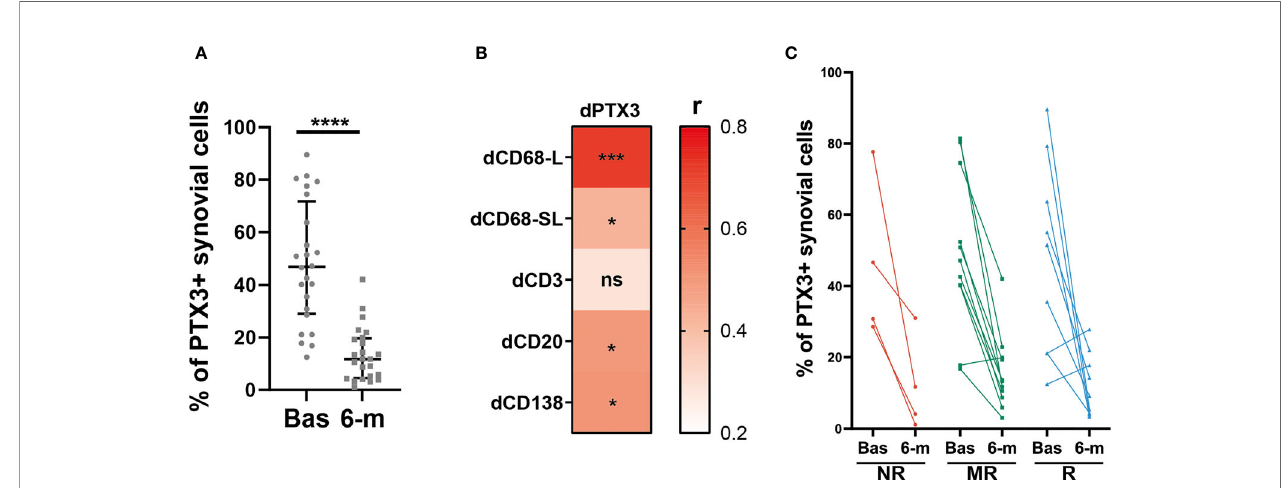
FIGURE 4 | Synovial PTX3 expression is signi fi cantly decreased after cs-DMARD treatment but independently of clinical response. (A) % of PTX3 positive synovial cells in paired patients at baseline and at 6-months after cs-DMARD treatment. Data are represented as median +/- interquartile range. ****p < 0.00001, as assessed by the Wilcoxon test. (B) Heatmap representing the correlation between dPTX3 synovial expression (calculated as the difference of expression between baseline and 6-months) and difference between semi-quantitative scores for in fl ammatory cells markers at baseline and at 6-months (dCD3, dCD20, dCD138, dCD68L, dCD68SL). The red scale represents the spearman r coef fi cient. *p < 0.05, ***p < 0.001, ns, non-signi fi cant. p-values and r coef fi cients were calculated using Pearson correlation test. (C) % of PTX3 positive synovial cells at baseline (Bas) and at 6-months (6-m) in non-responders (NR, red lines), moderate responders (MR, green lines) and good responders (R, blue lines) patients to cs-DMARD